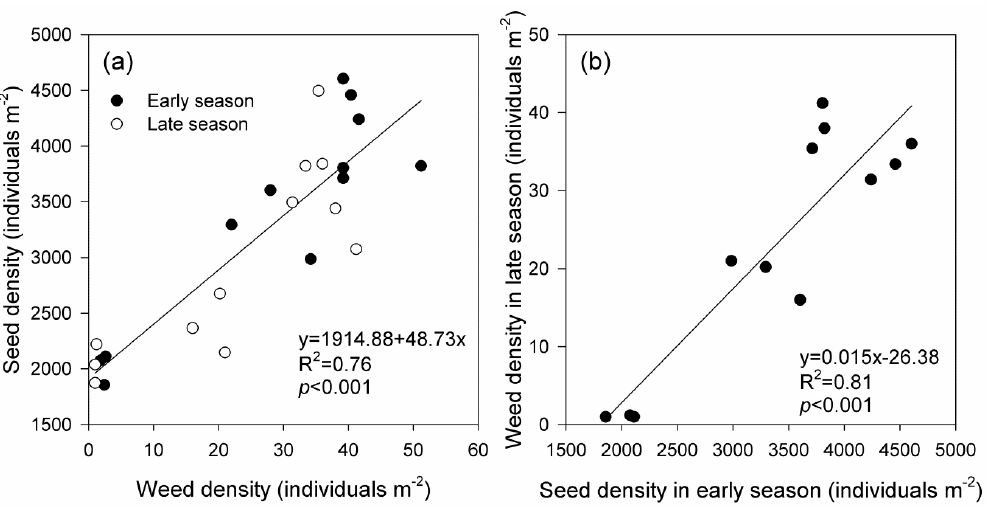
Figure 6. Correlations between soil seed bank density and weed density in the both seasons ( a ) and between seed density in the early season and weed density in the late season ( b ). The solid line indicates a significant linear relationship between the two indices in each panel.